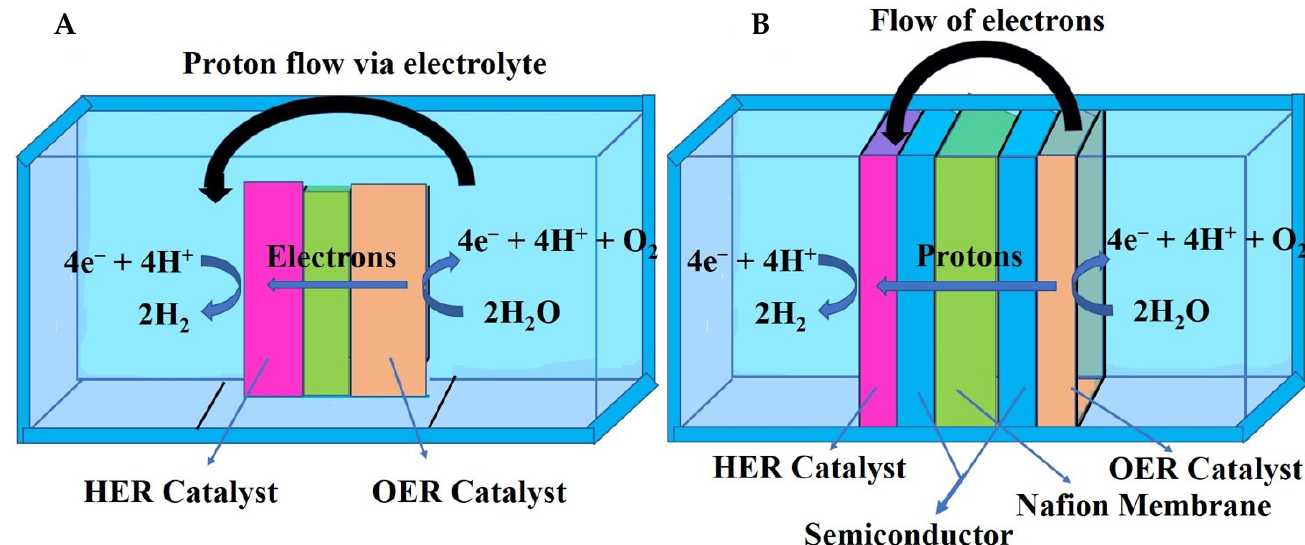
Figure 1. Artificial photosynthesis technology for solar energy into hydrogen processes: ( A ) wireless presentation and ( B ) wired configuration. Thus, it is preferable to use thinner catalyst layers in both situations. Adapted from [37].